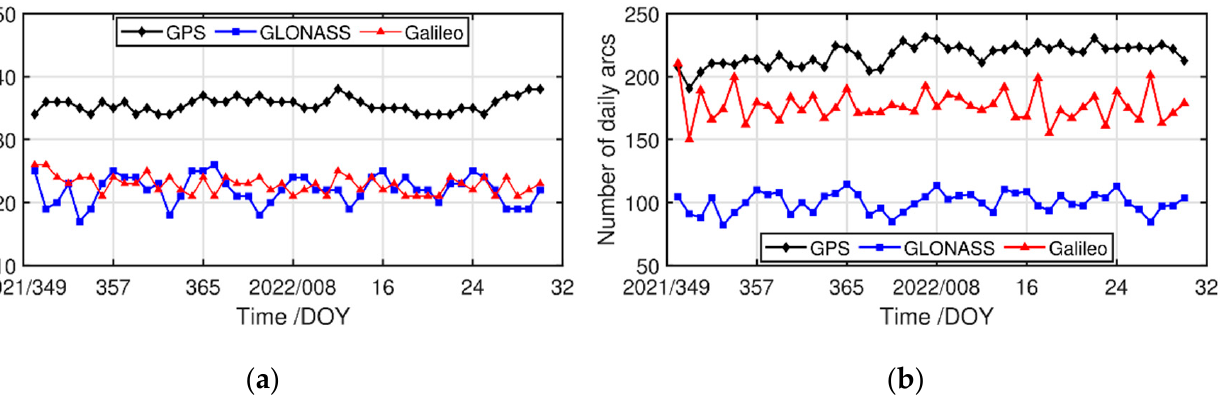
Figure 9. Number of daily PE arcs for GPS, GLONASS, and Galileo carrier-phase observations recorded from site SC02 during the experimental period. ( a ) Initial observation arcs; ( b ) extended observation arcs based on a sliding window.